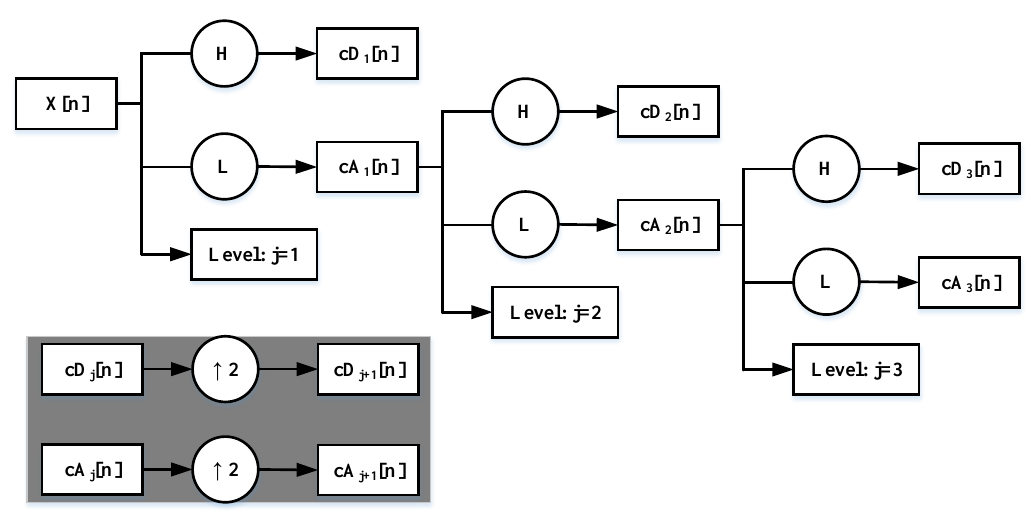
Figure 2. The ND-SWT decomposition